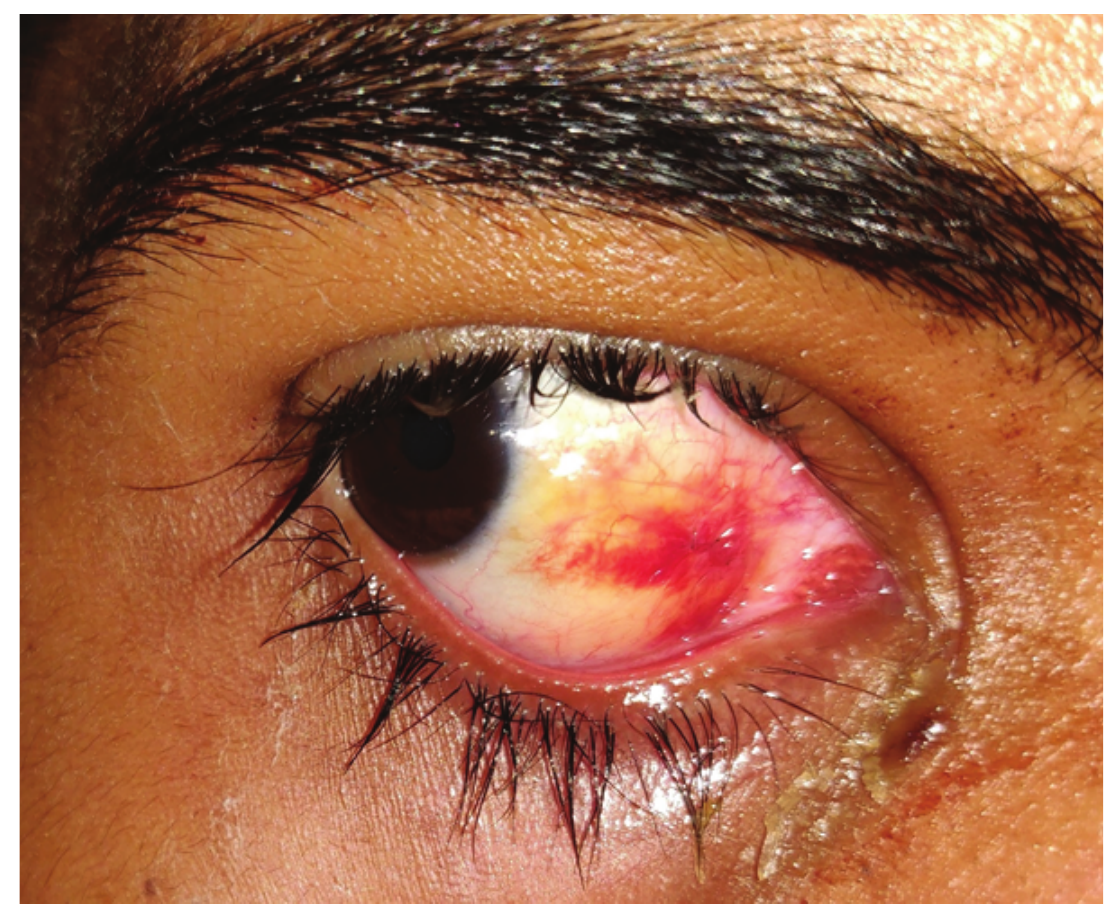
Figure 2. Image acquired one day after excision of the lesion. The conjunctival defect is apposed with 10–0 nylon sutures.